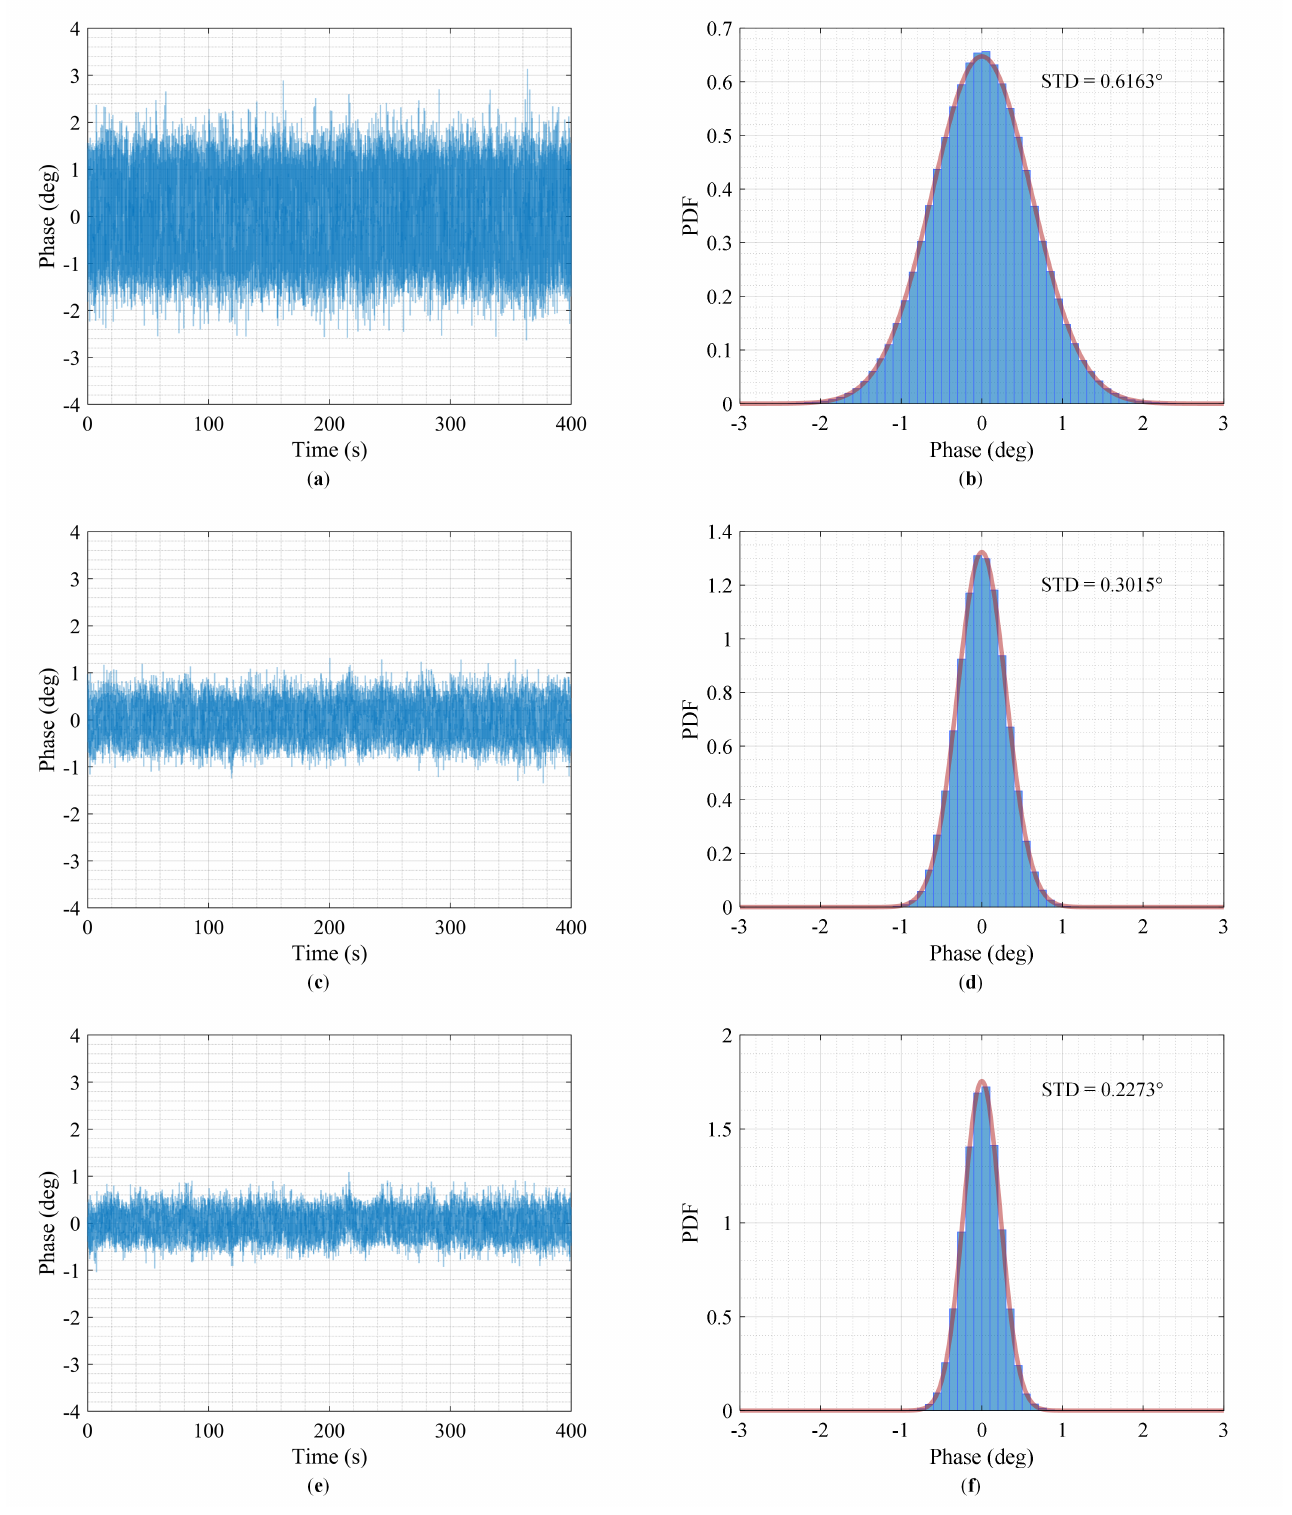
Figure 10. Residual phases. ( a ) Residual phase before denoising. ( b ) Statistical histogram of ( a ). ( c ) Residual phase after denoising by KF. ( d ) Statistical histogram of ( c ). ( e ) Residual phase after denoising by CS. ( f ) Statistical histogram of ( e